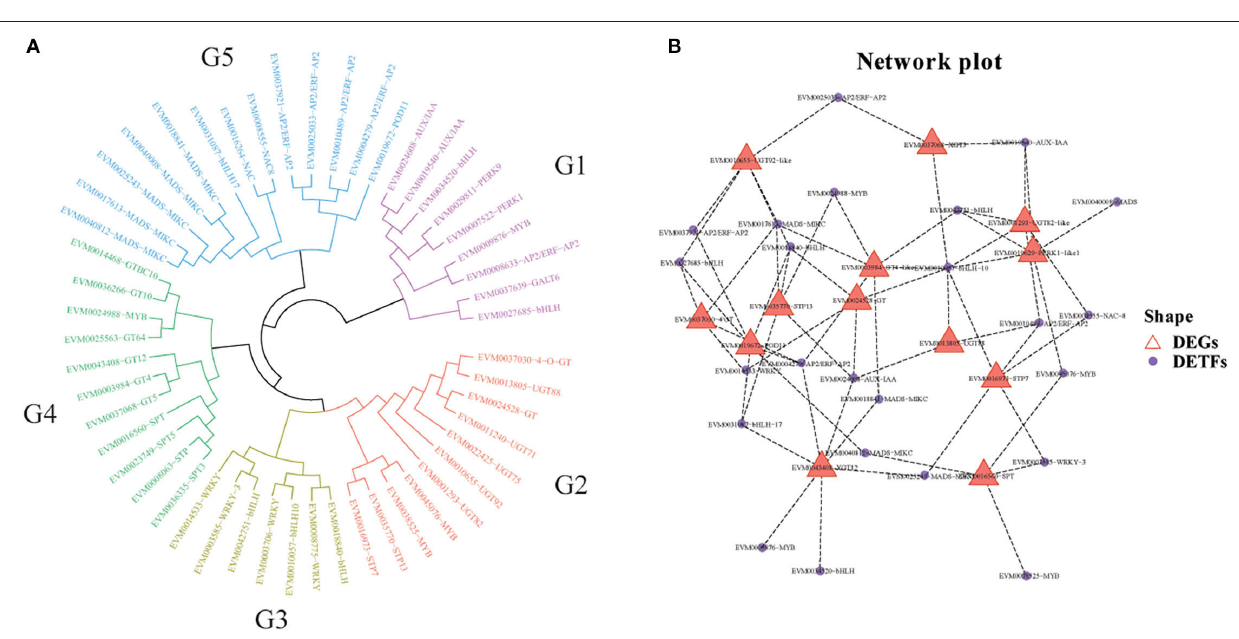
FIGURE 8 | Phylogenetic tree and co-expression networks between candidates differentially expressed transcription factors (DETFs) and genes (DEGs) under cold stress. (A) Phylogenetic tree of DEGs and DETFs; (B) co-expression network between DEGs and DETFs.